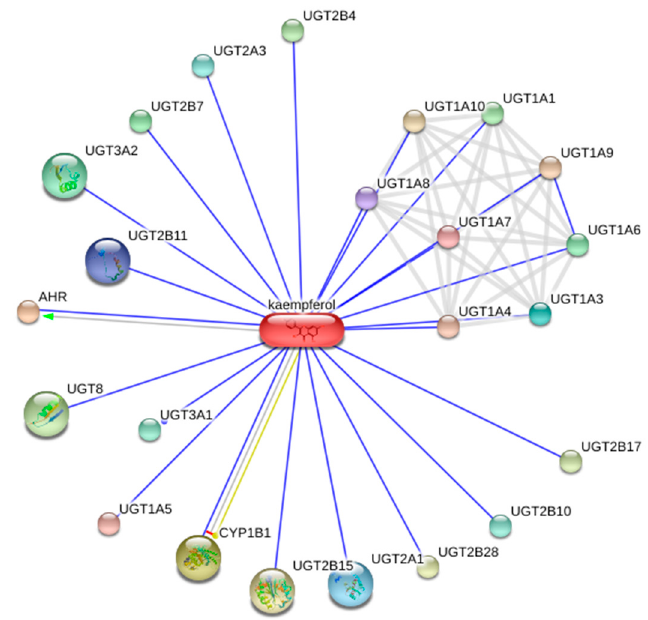
Figure 2. Direct protein–protein and protein–compound interactions between human targets of kaempferol. This figure was constructed using the default settings of the STITCH database (http://stitch.embl.de/). The uridine 5’-diphospho-glucuronosyltransferase (UGT), aryl hydrocarbon receptor (AHR), and cytochrome P450 family 1 subfamily B member 1 (CYP1B1) proteins groups are dominant.